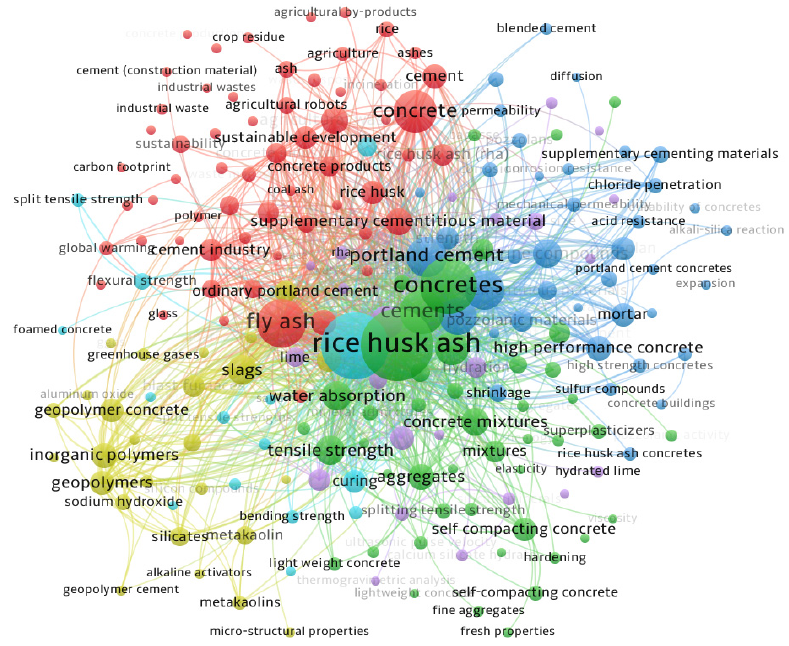
Figure 3. Importance of RHA in the construction industry.